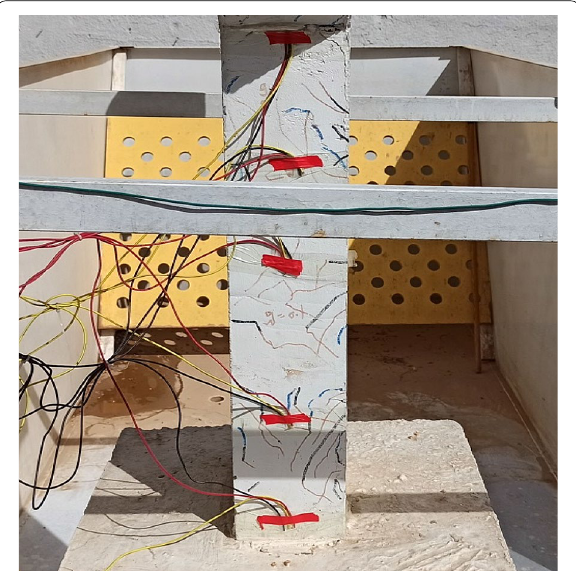
Fig. 9 Displacement and acceleration sensors distribution along pier height.